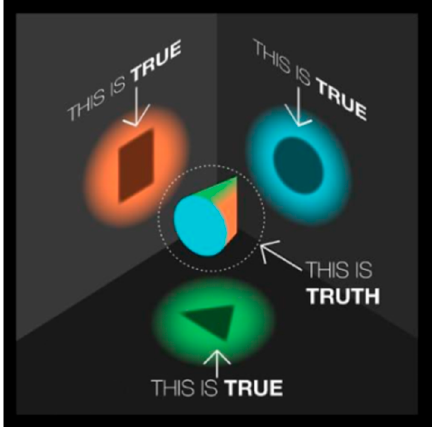
Figure 10. “Our perception of Truth depends on our viewpoint” (Adapted from [34]).